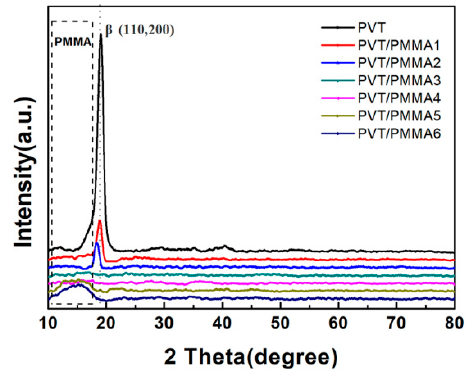
Figure 4. XRD patterns of PVT/PMMA composites with different contents of PMMA.